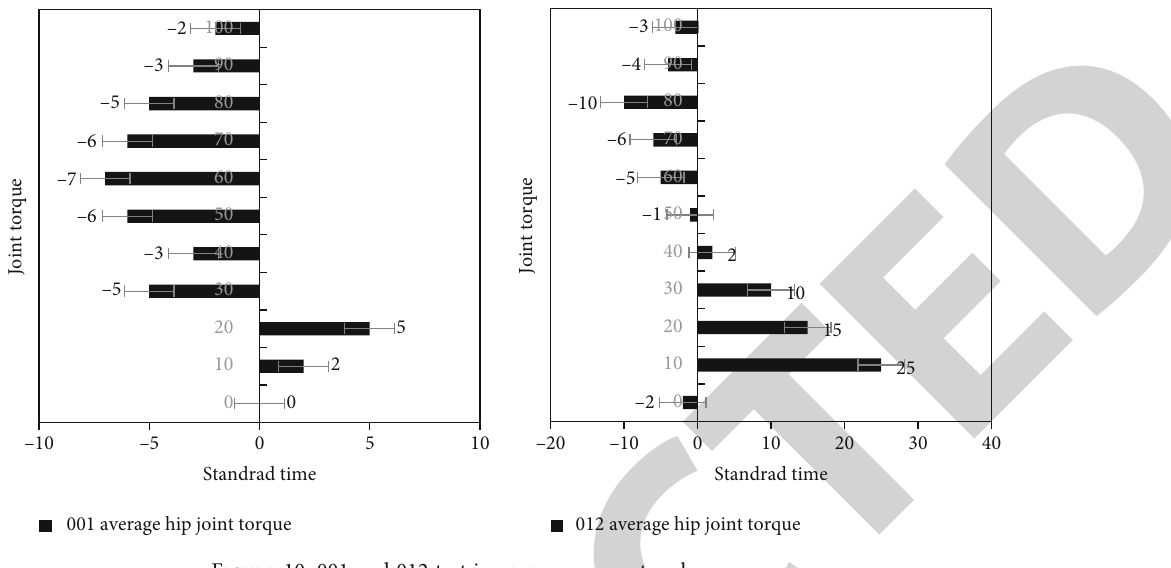
Figure 10: 001 and 012 test jump pressure center change